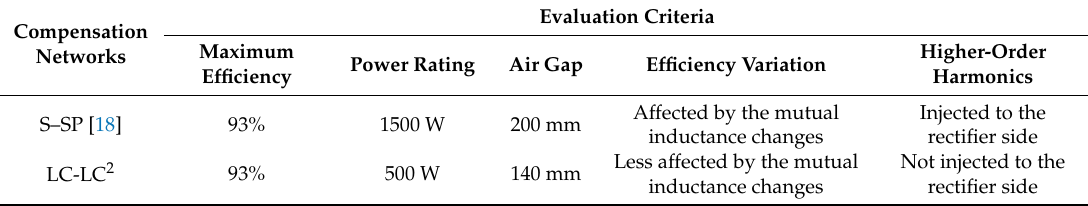
Table 2. Comparison of LC-LC2 compensation with S–SP 2 compensation.